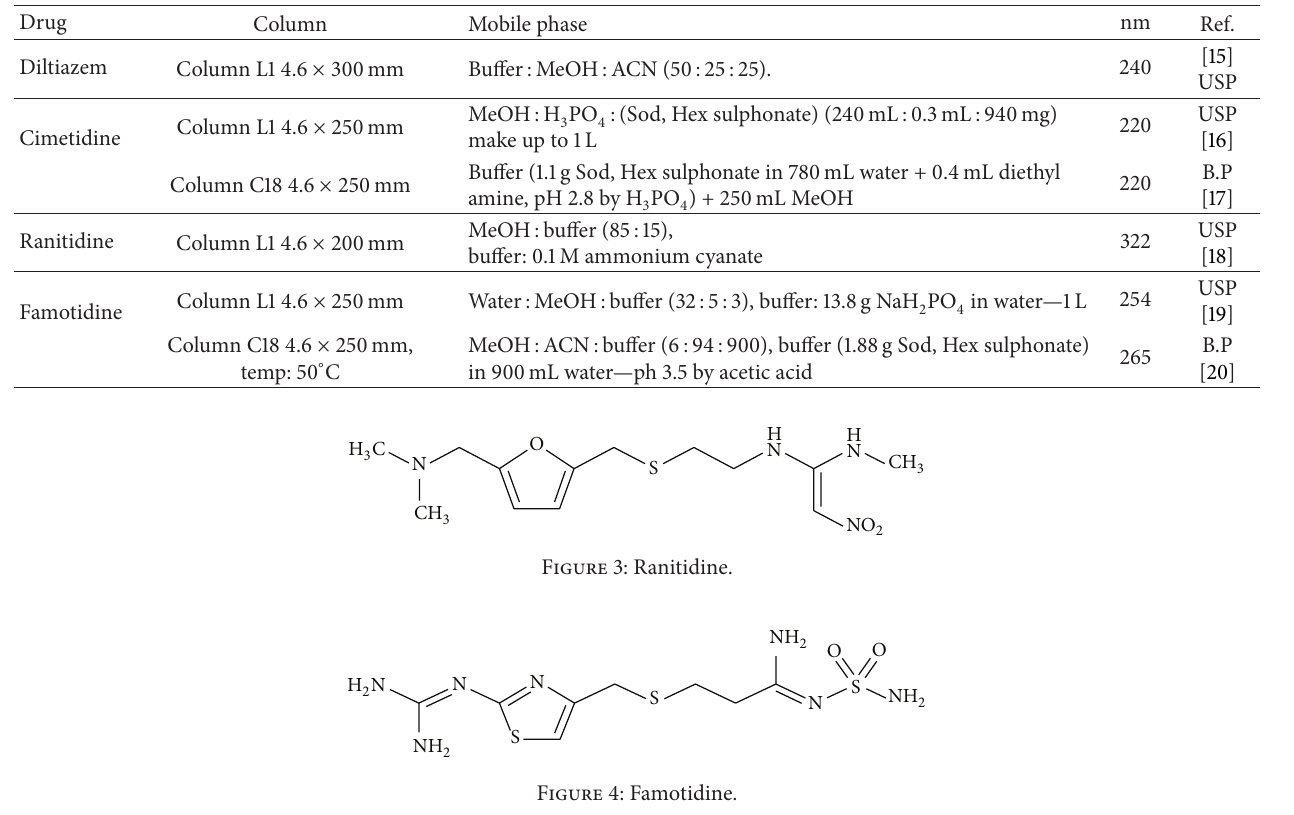
Table 1: Official methods of analysis.